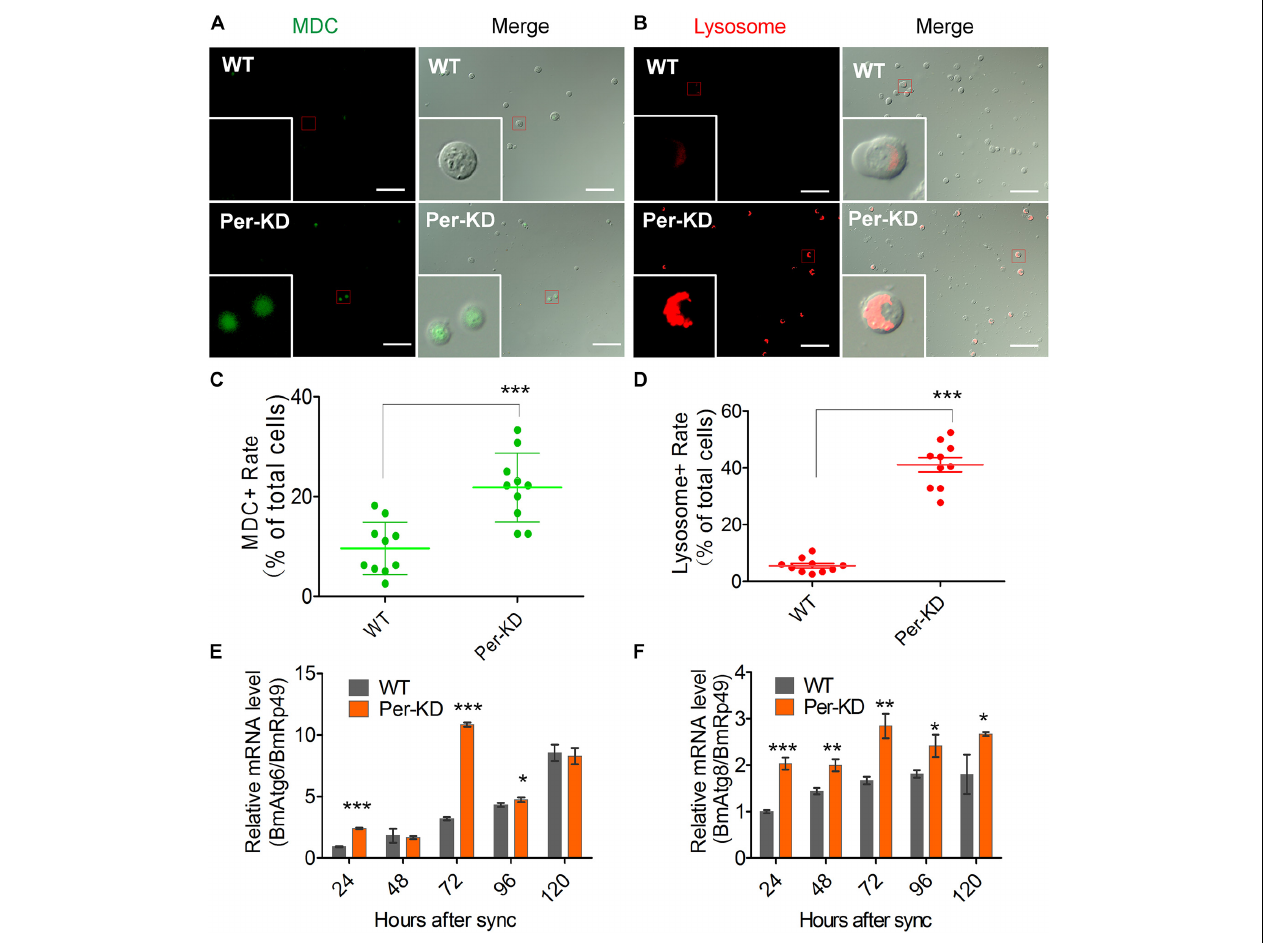
FIGURE 5 | Autophagy was induced by BmPer gene knockdown. Autophagy was assayed in WT and Per-KD cells at 24, 48, 72, 96, and 120 h after synchronization. Cell dyeing were performed at 120 h after the synchronization process. (A) Monodansylcadaverine (MDC) staining is visible as green fluorescence in autophagosomes and (B) Lyso-Tracker Red fluorescence staining shows lysosomes in autophagic cells at 120 h. (C) Percentage of positive MDC staining. (D) Percentage of positive lysosome staining. (E,F) qRT-PCR assay of relative BmAtg6 (E) and BmAtg8 gene transcription (F) after synchronization. Bar = 100 µ m. ∗ p < 0.05, ∗∗ p < 0.01, ∗∗∗ p < 0.001, ( n =